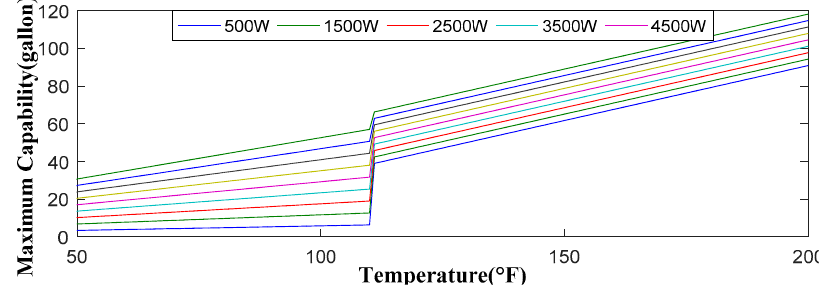
Figure 5. Maximum capability given different tank temperature and input power with base temperature set at 110 °F.